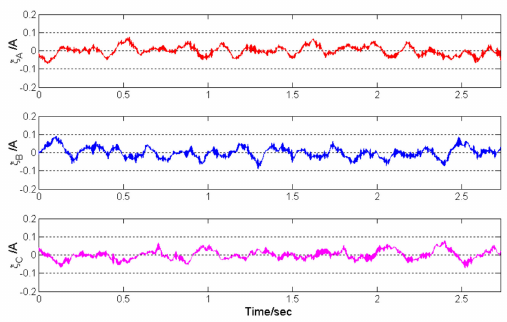
Figure 17. Harmonic currents of i d = 0 control.